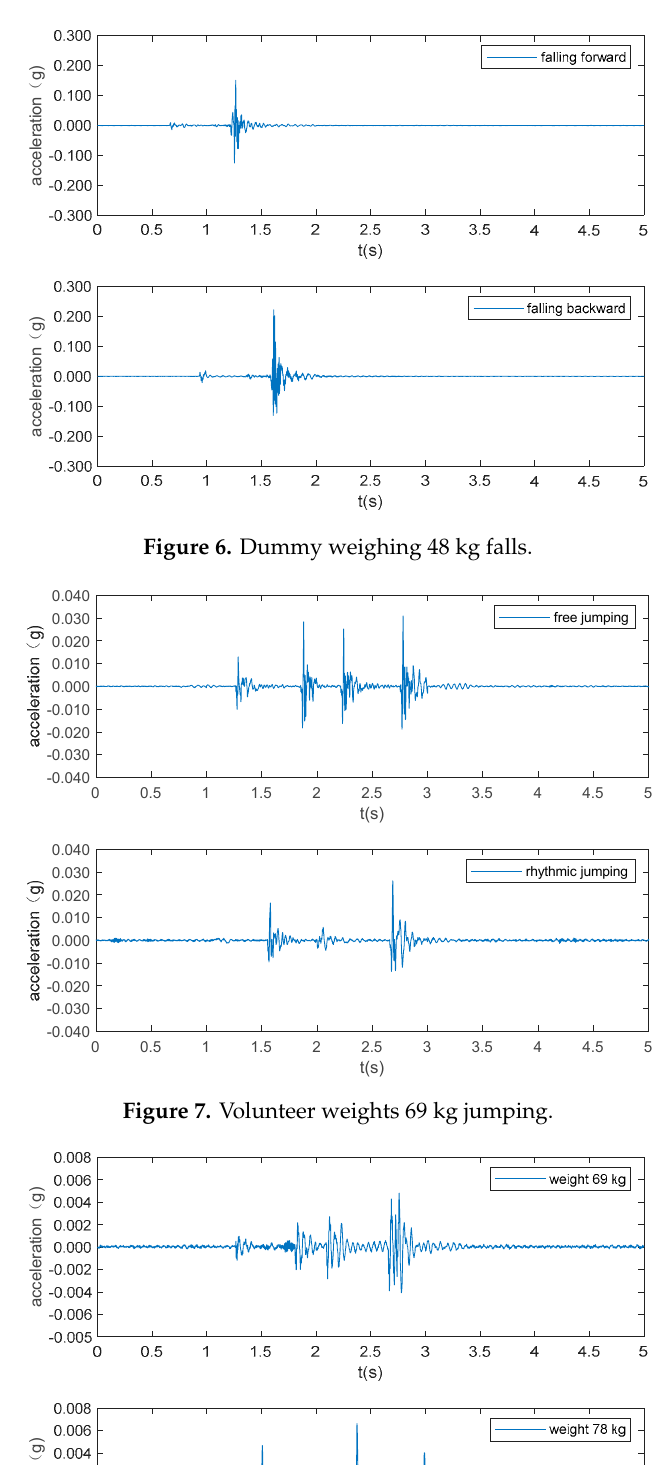
Figure 5. Dummy weighing 75 kg falls.